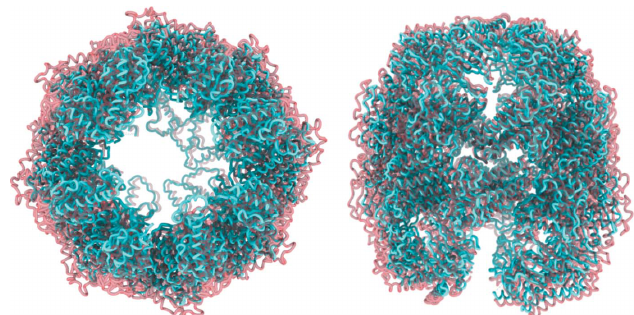
Figure 6 Deformation applied to one of the 30 CCT models obtained by the NMA- based approach called adaptive ANM described in Experiment 2. The deformation was computed using the cryo-EM maps simulated from the 30 models. The original atomic structure in the open state is shown in pink and the deformed version in the closed state in cyan. The results show that the deformation coefficients (cid:2) l , n , m computed with maps can be effectively applied to the atomic space of the model to approximate geometrically the conformation represented by the cryo-EM map at the level of